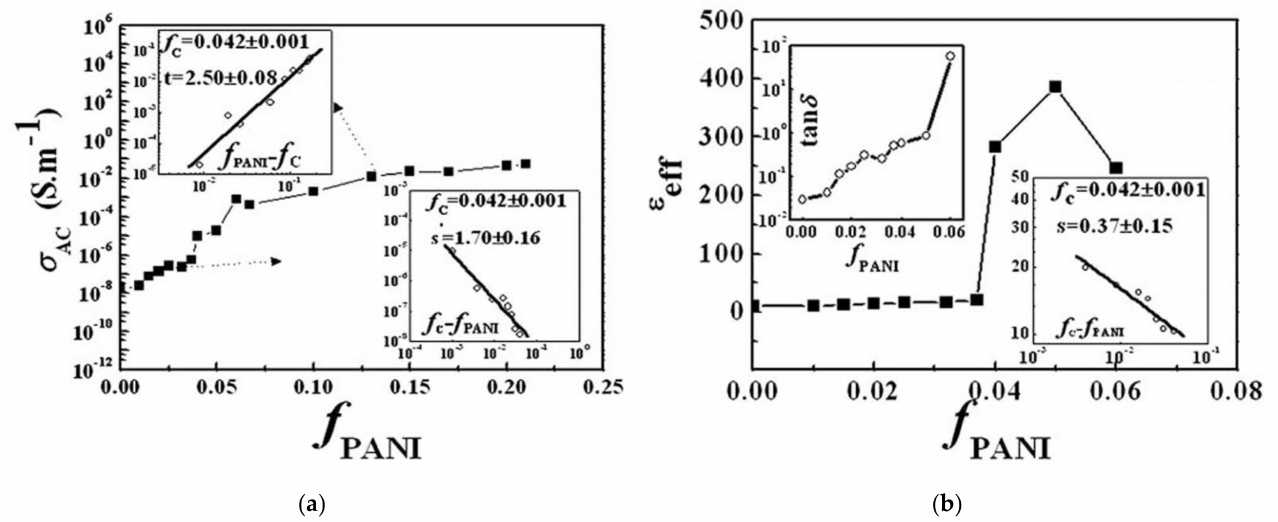
Figure 8. ( a ) The relationship between AC conductivity of PANI/PVDF composite and f PANI ; ( b ) The relationship between the effective dielectric constant of PANI/PVDF composite and f PANI . Reprinted with permission from [101]. Copyright (2010), Royal Society of